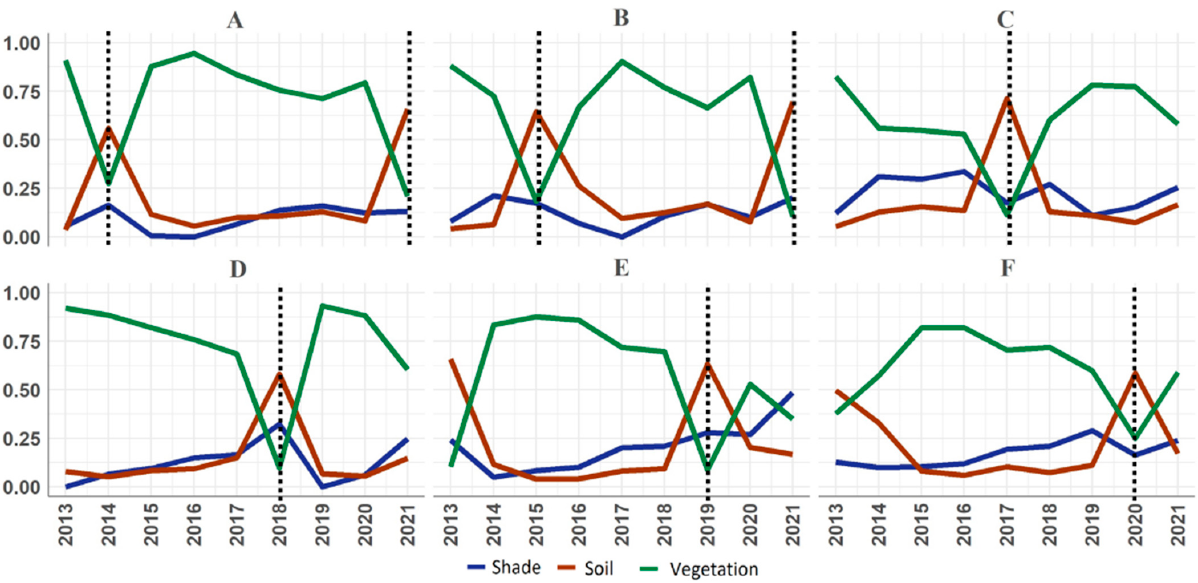
Figure 16. Phenological assessment of eucalypt plantation in the pilot area during the 2013–2021 time period, based on the fraction-image time series. We can observe the eucalypt rotation cycle for the six analyzed sample plots ( A – F ), as shown in Figure 3.